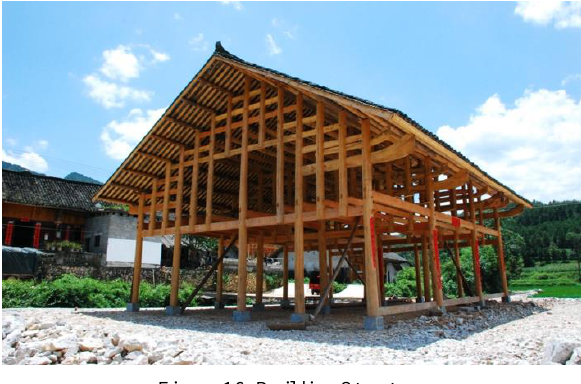
Figure 16. Building Structure.